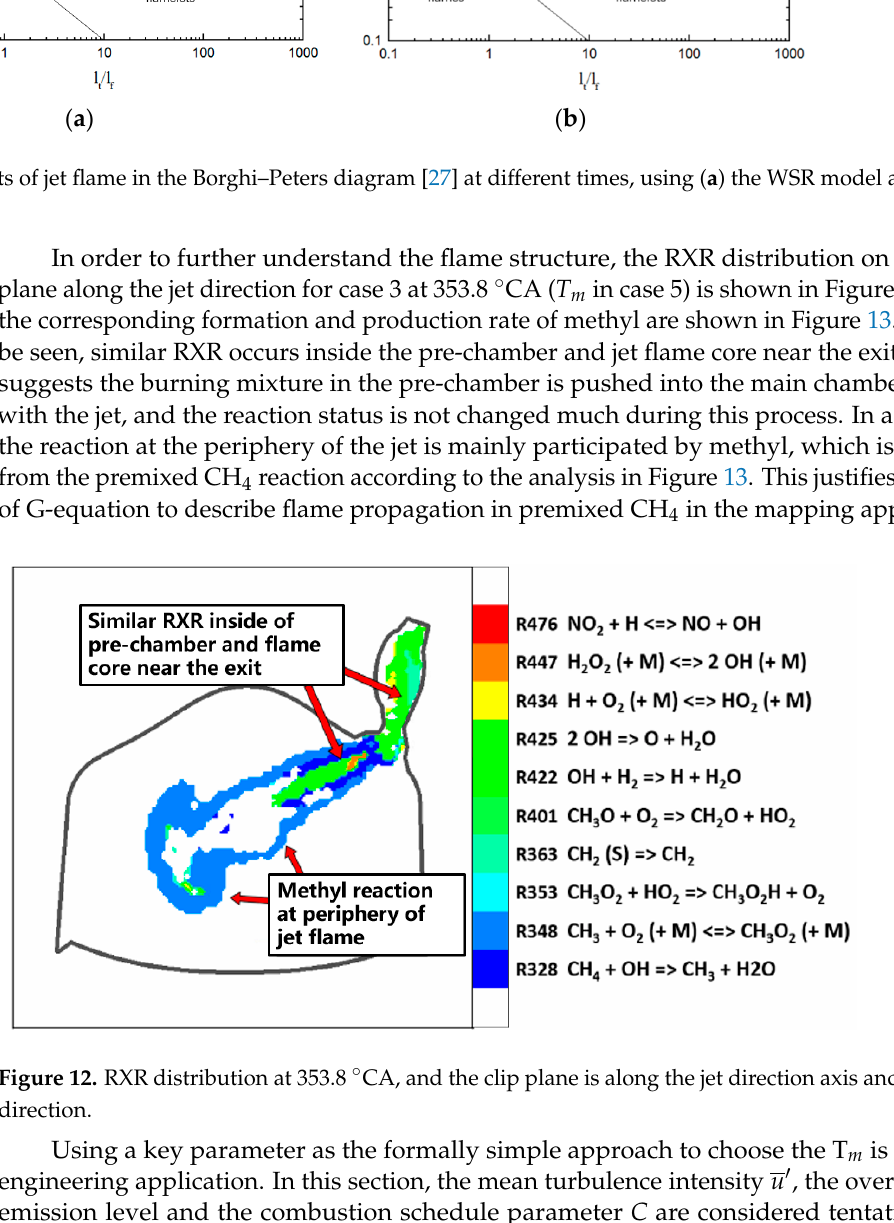
Figure 11. The discrete points of jet flame in the Borghi–Peters diagram [27] at different times, using ( a ) the WSR model and ( b ) the G-equation model.